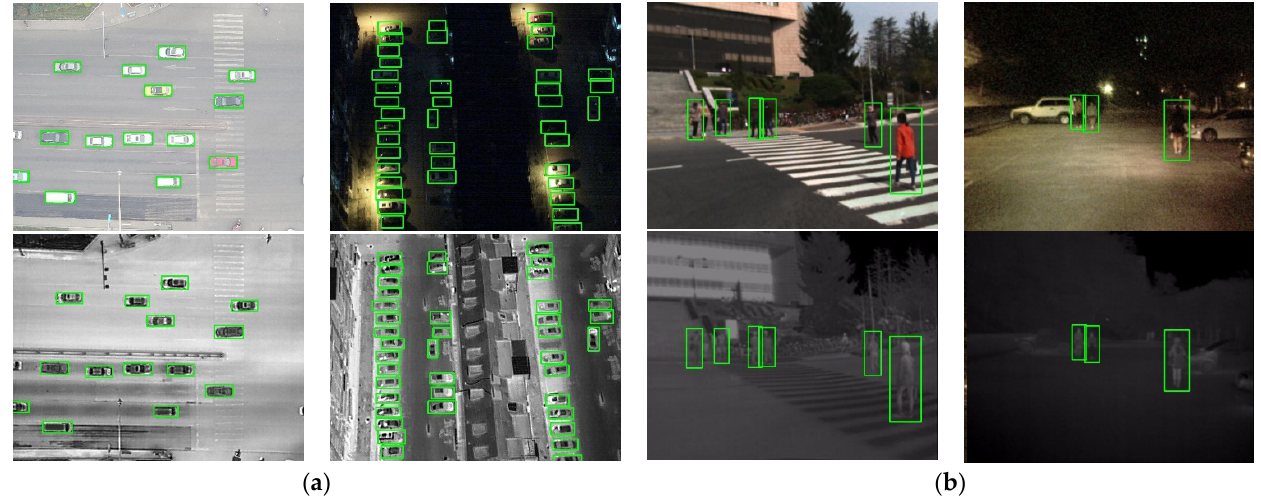
Figure 4. Sample visualization. ( a ) some images of DroneVehicle remote sensing dataset; ( b ) some images of KAIST pedestrian dataset. The first row is the RGB image, the second row is the corresponding infrared image.